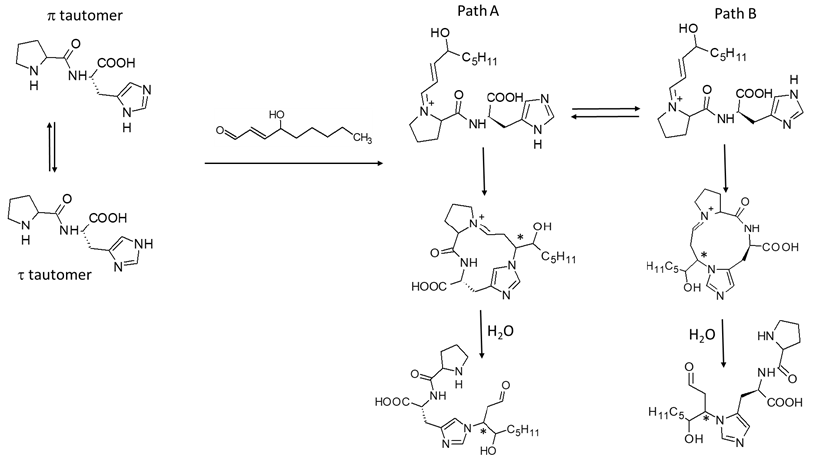
Figure 2. Possible paths involving the two histidine tautomers for the quenching mechanism of Pro-His with HNE (the final adducts are displayed only in their open form for simplicity; * indicates the introduced stereocenters).